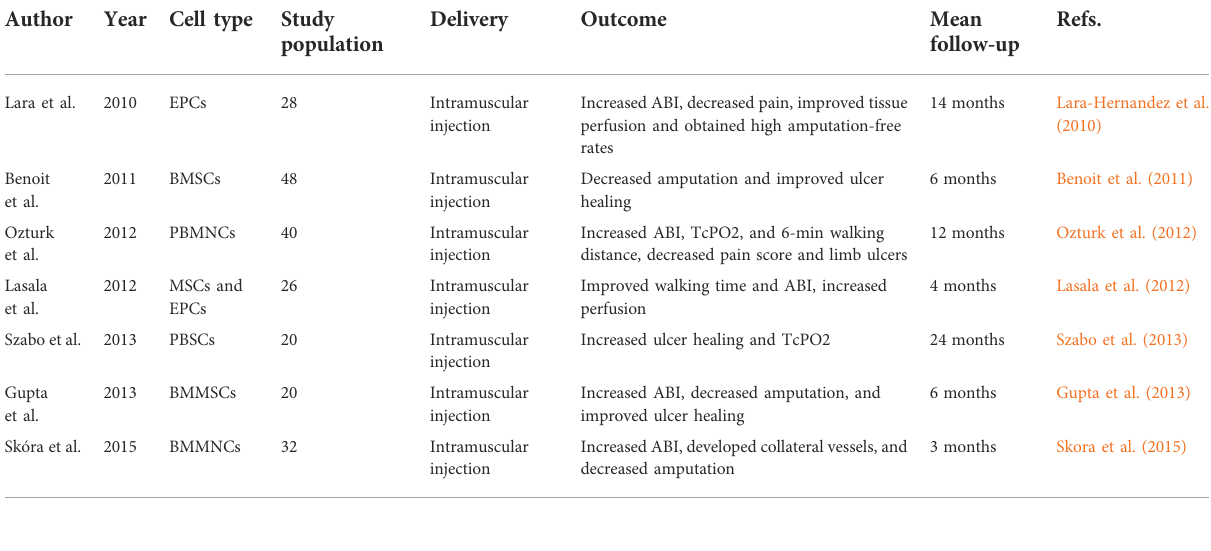
TABLE 1 Clinical trials based on cell therapy for LEAD patients.